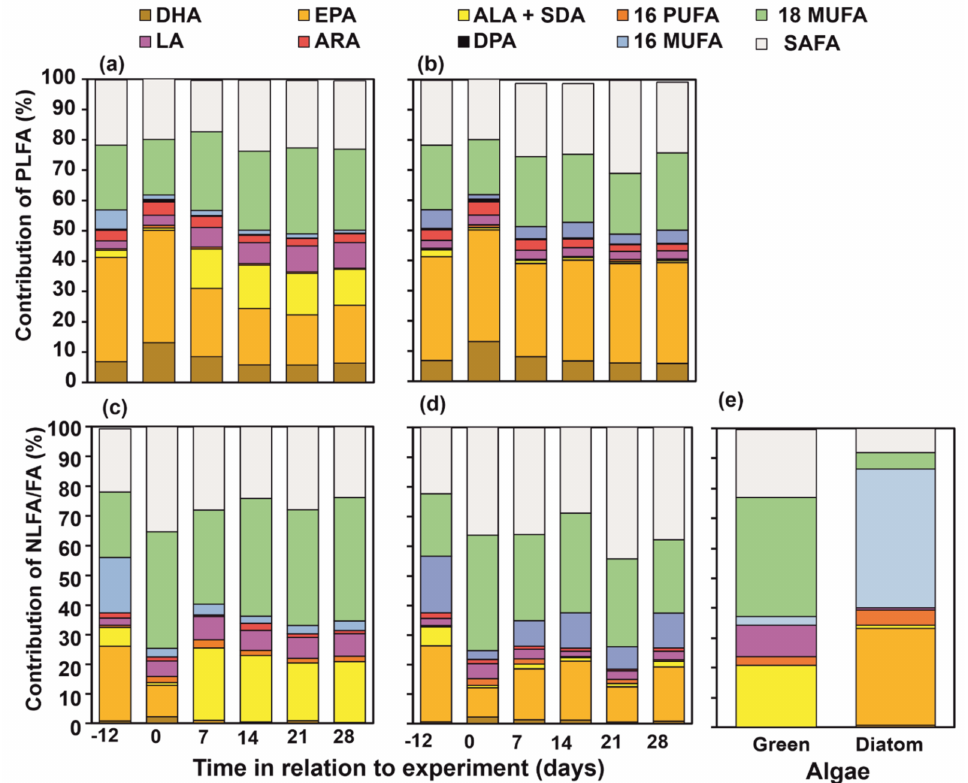
Figure 2. Phospholipid fatty acid (PLFA) and neutral lipid fatty acid (NLFA) and composition of Pallaseopsis quadrispinosa in ( a , c ) green algae ( Acutodesmus sp.) and ( b , d ) diatom ( Diatoma tenuis ) treatments. Day refers to the age of initial wild-caught amphipods ( − 12) in relation to the start (day 0, starved 12 days) of the feeding experiment. ( d ) Diet fatty acid composition: green ( Acutodesmus sp.) and diatom ( Diatoma tenuis ). ( e ) Total fatty acid composition of green algae ( Acutodesmus sp.) and diatom ( Diatoma tenuis ) used in the experiment. Abbreviations: SAFA = saturated fatty acids, 18 MUFA = 18 monounsaturated fatty acids, 16 MUFA = 16 monounsaturated fatty acids and 16 PUFA = 16 polyunsaturated fatty acids.